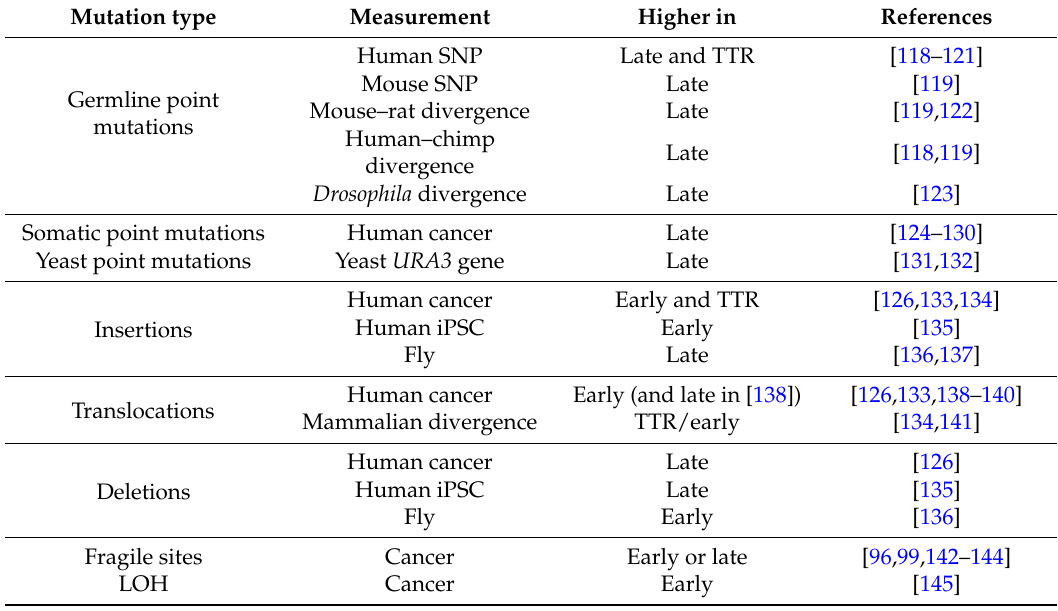
Table 2. Studies linking replication timing to